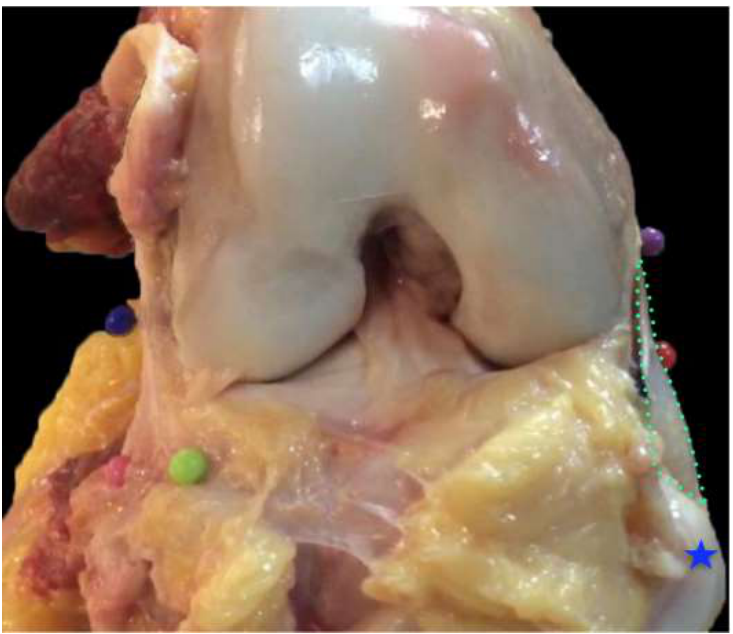
Figure 4. Right knee, anterior side. The patella (blue star) has been reflected. The MPFL (and its width) is depicted inside the green dotted line.